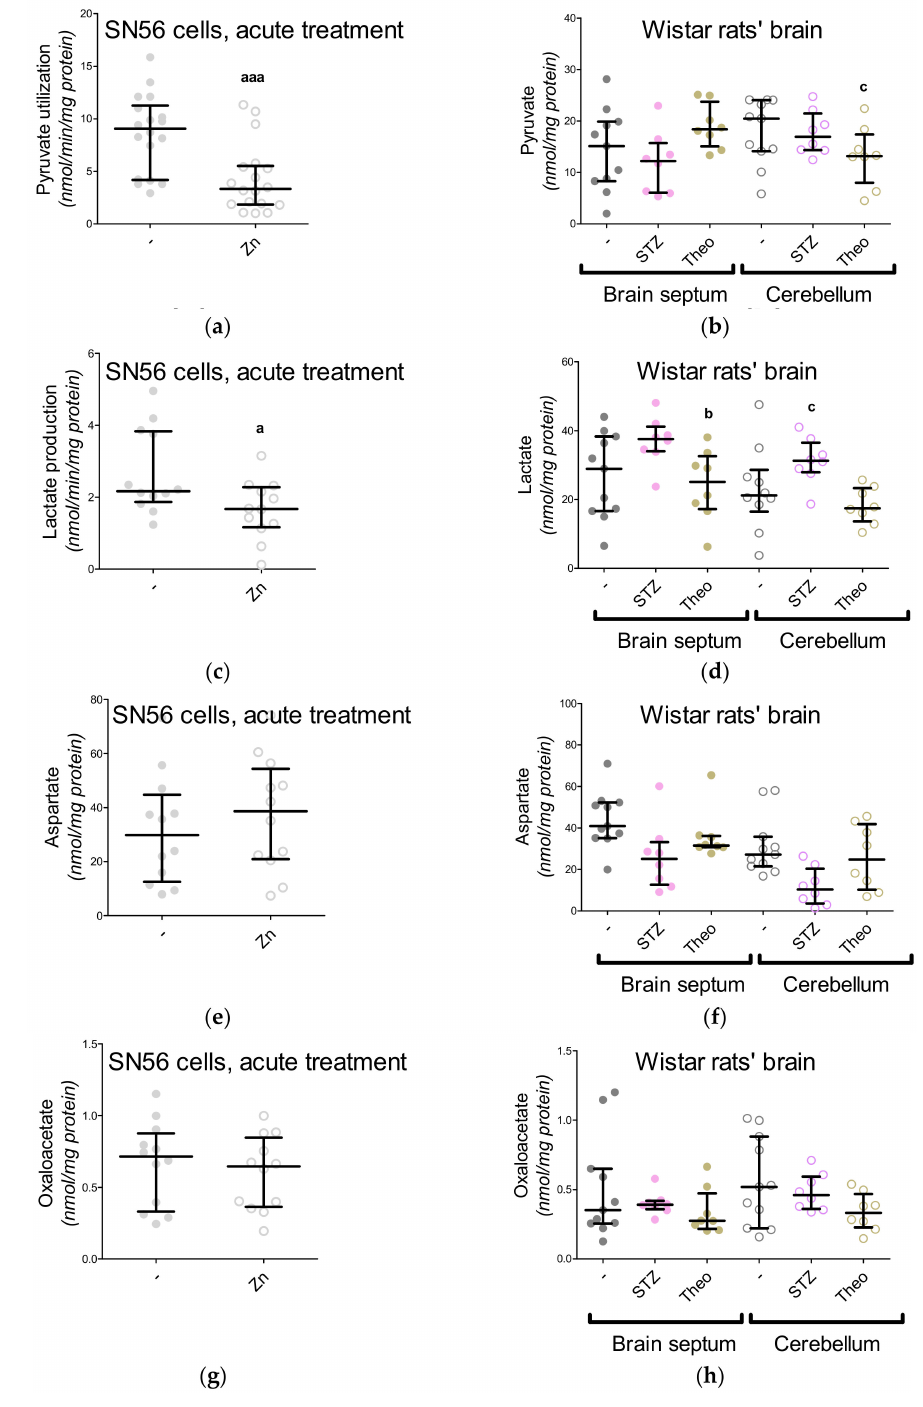
Figure 8. The levels of metabolites linked with malate–aspartate and lactate shuttles measured in SN56 cells ( a , c , e , g ) and Wistar rats’ brain tissues ( b , d , f , h ); ( a , b ) pyruvate consumption; ( c , d ) lactate production; ( e , f ) aspartate level; ( g , h ) oxaloacetate level. Data are median (25th–75th percentile)